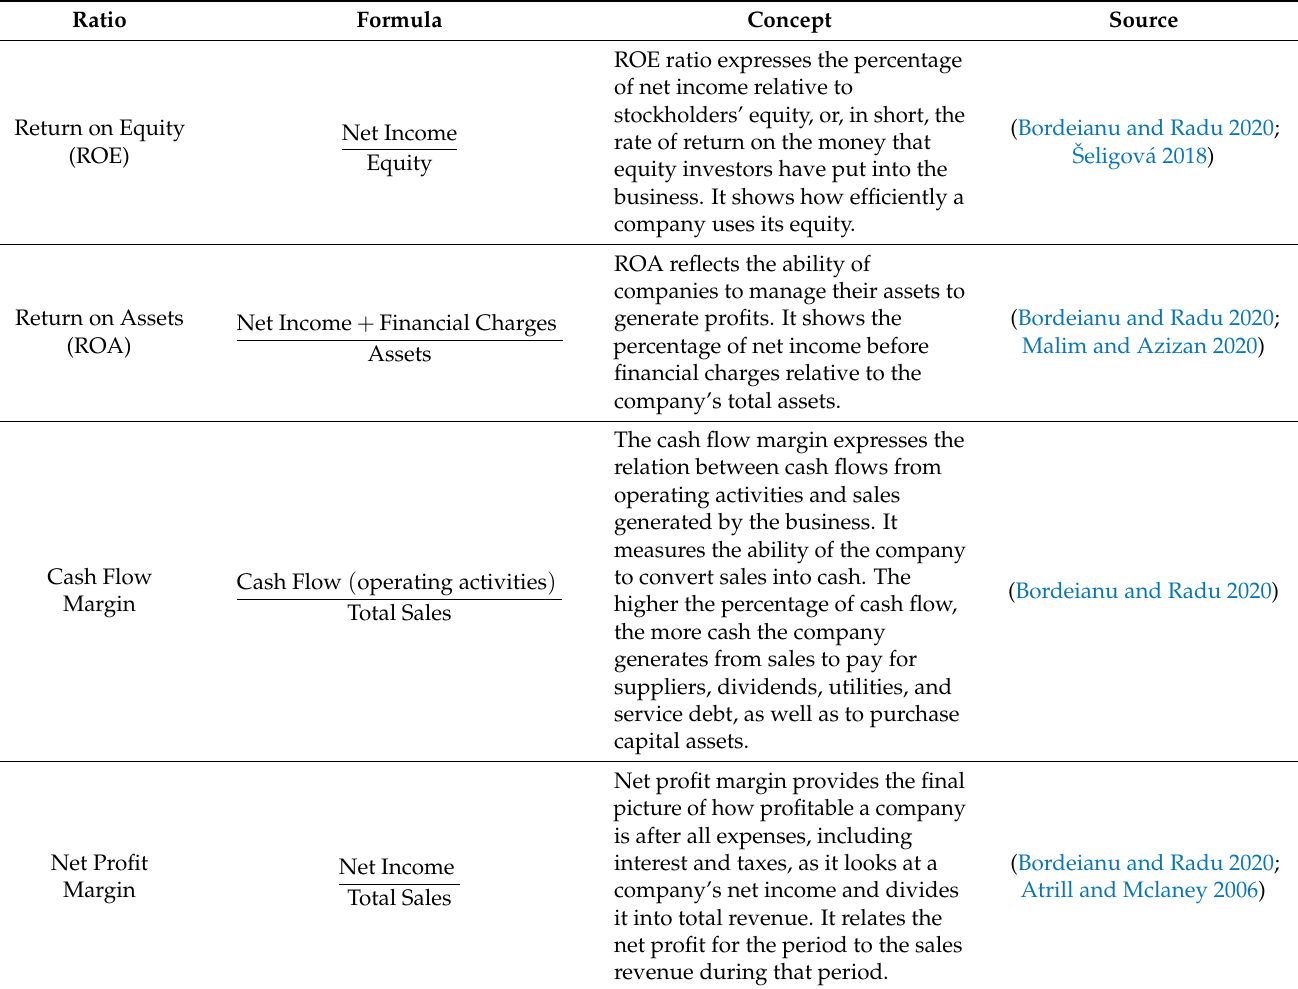
Table 3. Profitability